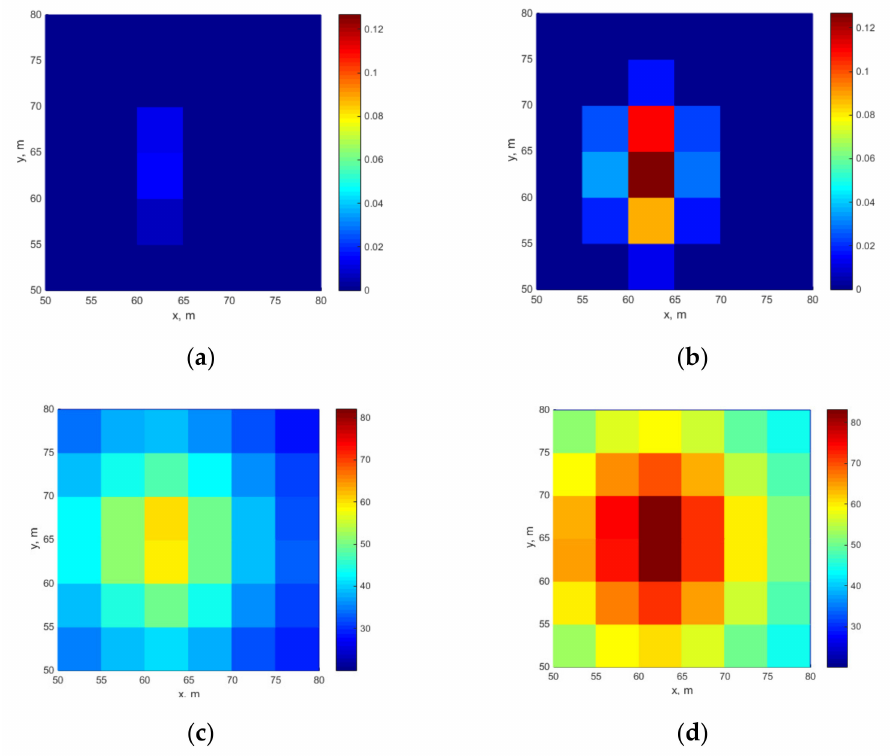
Figure 11. Profiles of the calculated water saturation and temperature: ( a ) 400 days, water saturation; ( b ) 800 days, water saturation; ( c ) 400 days, temperature; ( d ) 800 days,